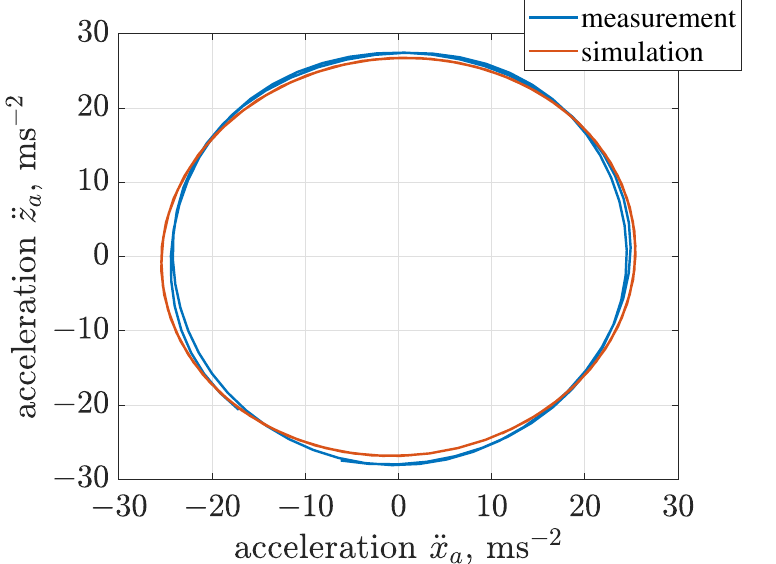
Figure 10. Comparison of trajectories of screen vibration acceleration evaluated for measurement and simulation results.